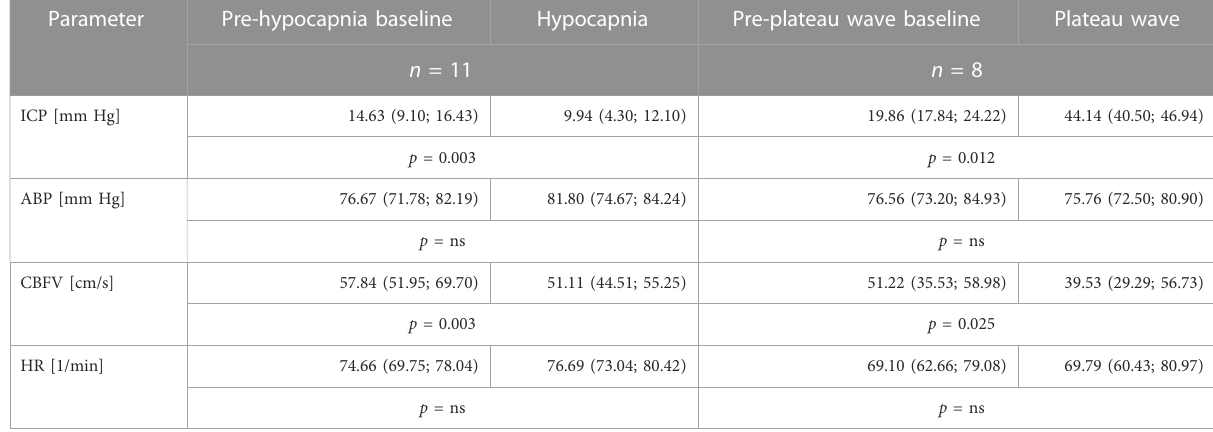
TABLE 1 Medians, upper quartiles, and lower quartiles (in brackets) of physiological parameters: intracranial pressure (ICP), arterial blood pressure (ABP), cerebral blood fl ow velocity (CBFV) and heart rate (HR).